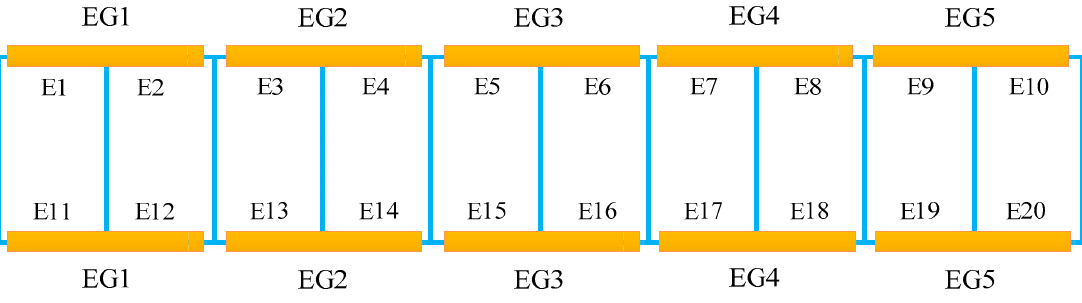
Table 2. Definition of element groups for the steel truss bridge model.